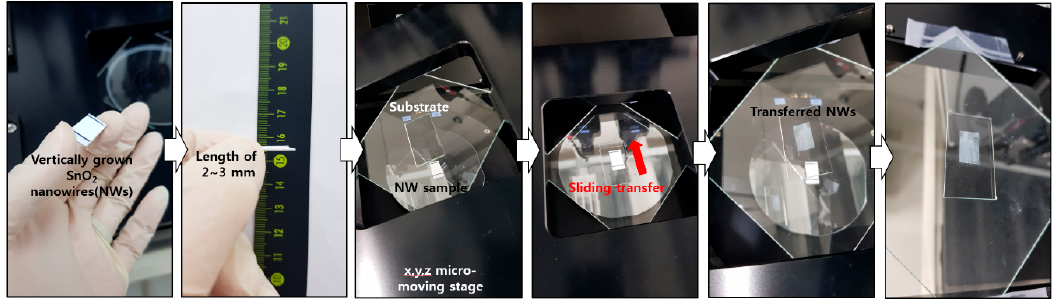
Figure A3. Sliding transfer method. The x, y, z moving stage was used to transfer NWs onto the desired substrate.